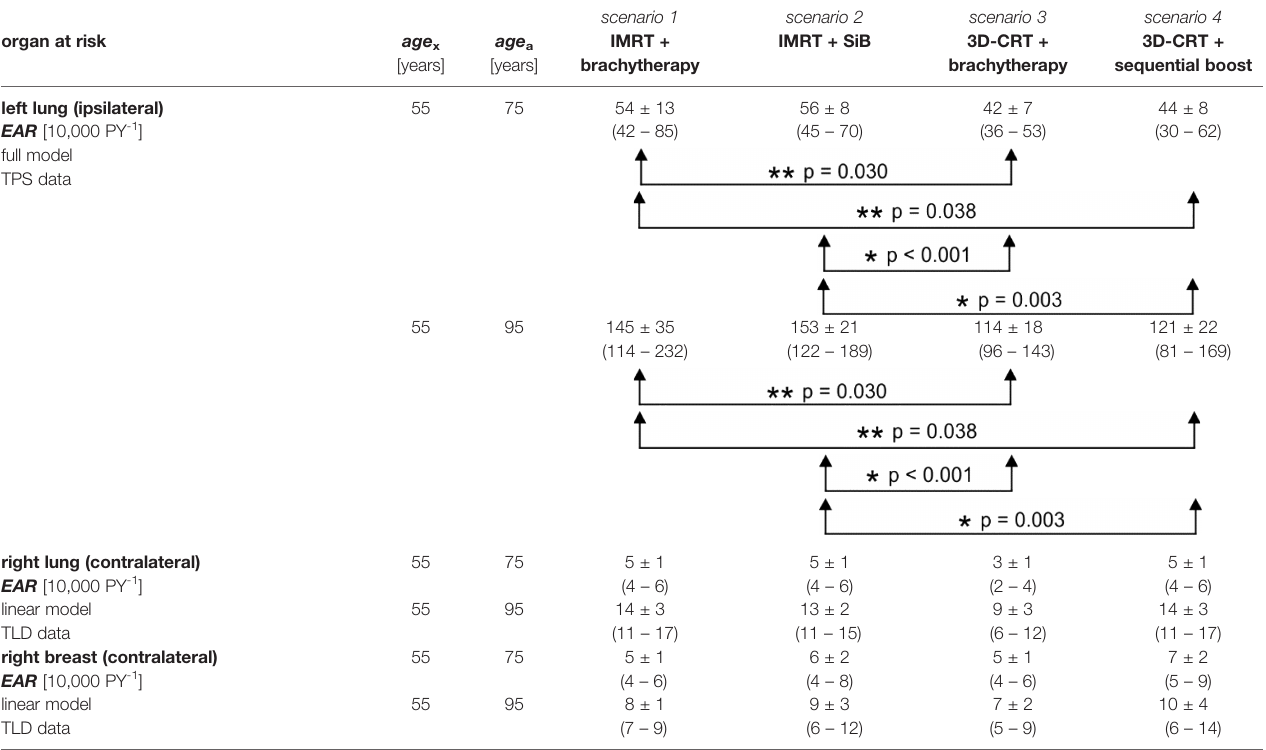
TABLE 4 | Secondary cancer risk for different organs at risk calculated using the TPS data and the TLD